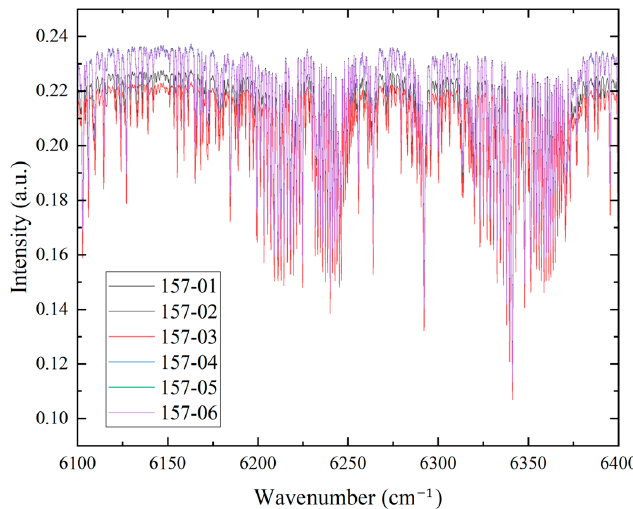
Figure 19. Spectral fluctuation during one measurement.